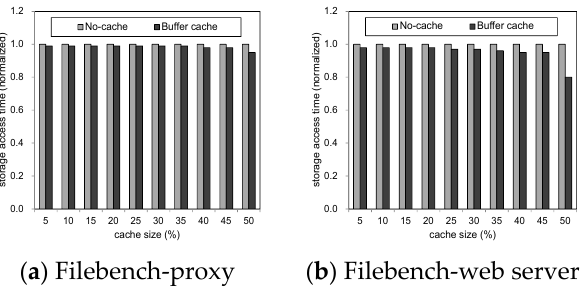
Figure 6. Performance effects of the buffer cache when storage is the RAMDisk.